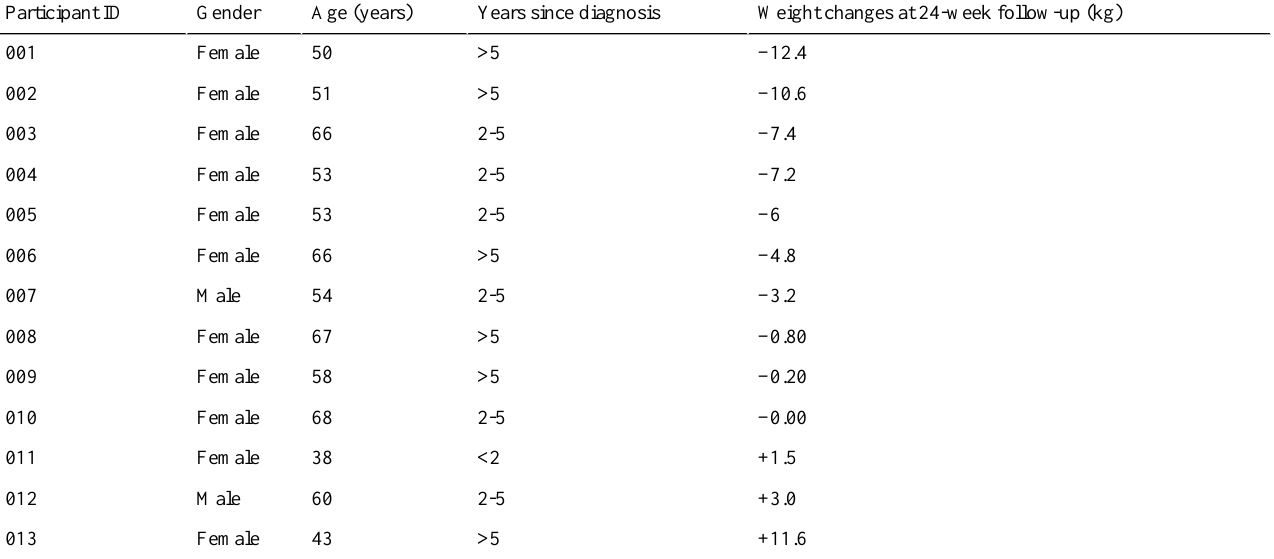
Table 1. Characteristics of the 13 participants interviewed in this